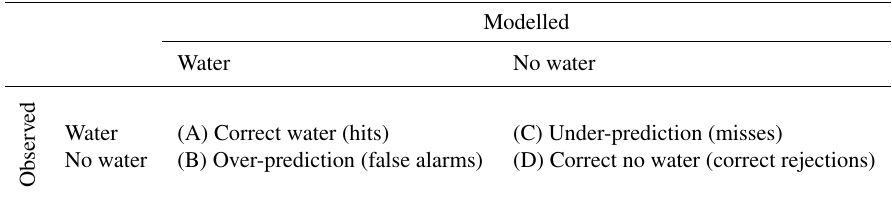
Table 1. Contingency table (after Stephens et al., 2014 and Mason,